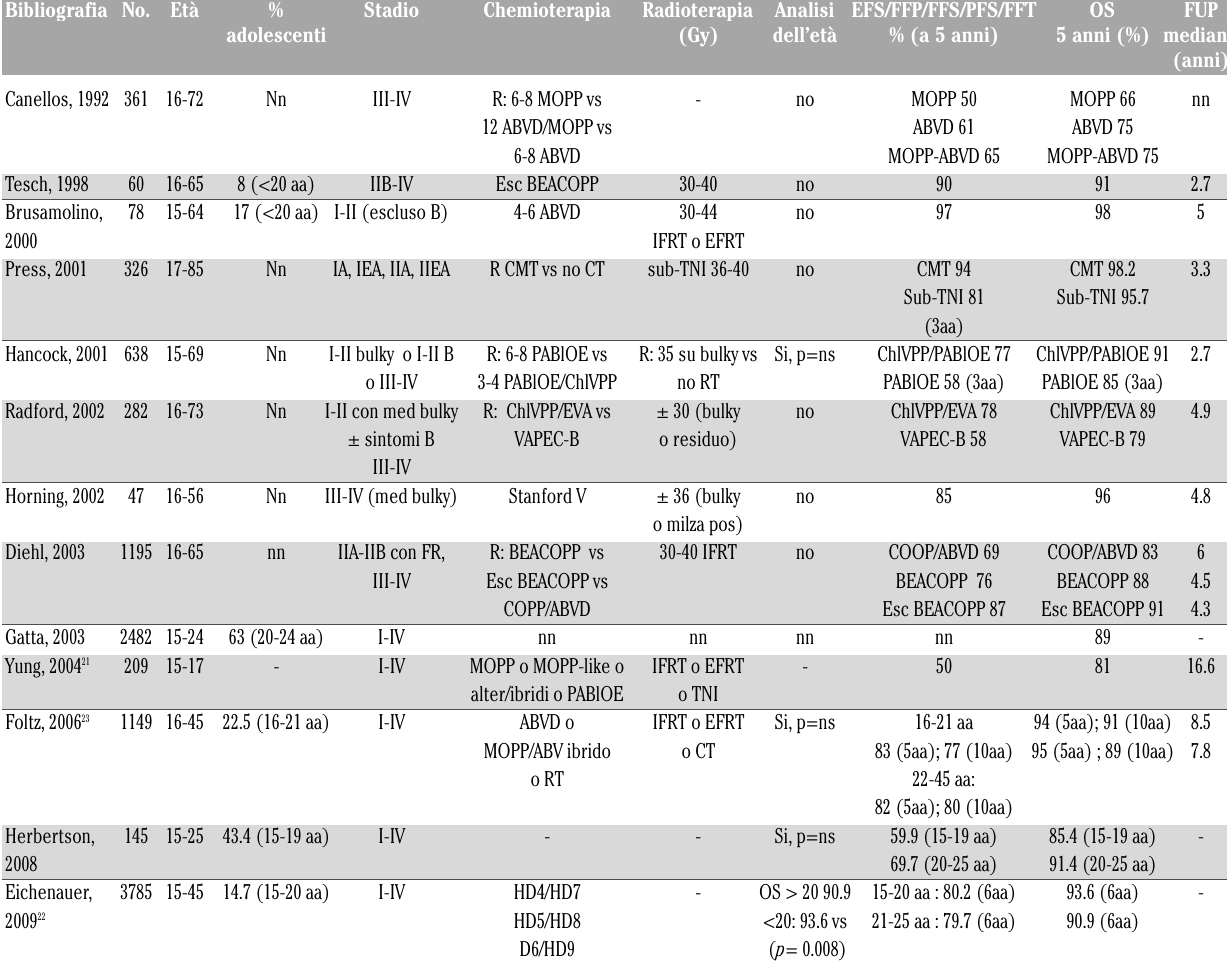
Tabella 2. Studi dell’adulto che includono adolescenti. Bibliografia No.